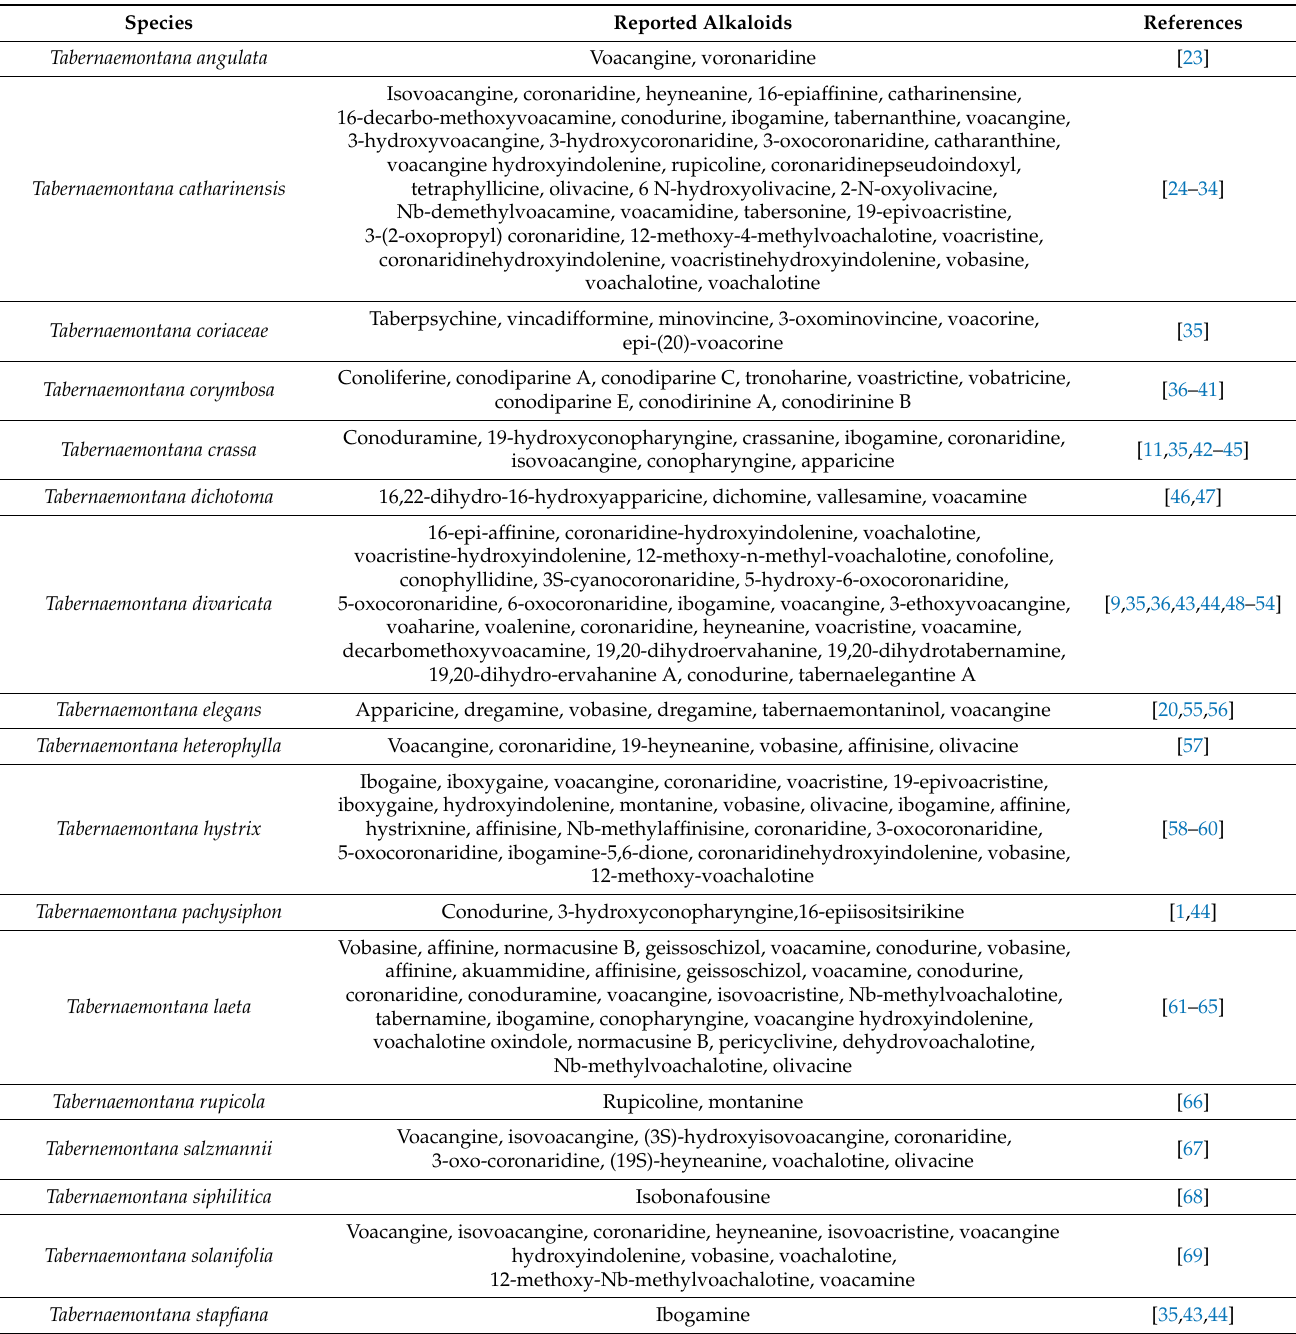
Table 1. Major alkaloids isolated within the genus